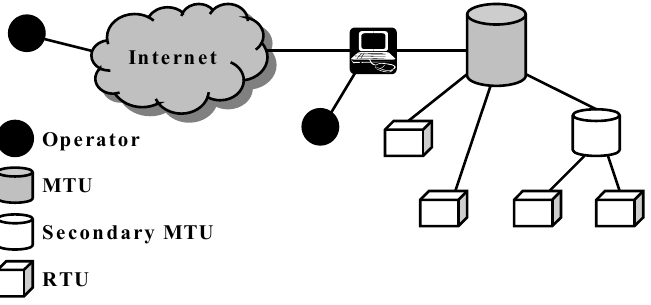
Figure 5. Architecture of a modern Supervisory Control And Data Acquisition (SCADA) system, connected to Internet.